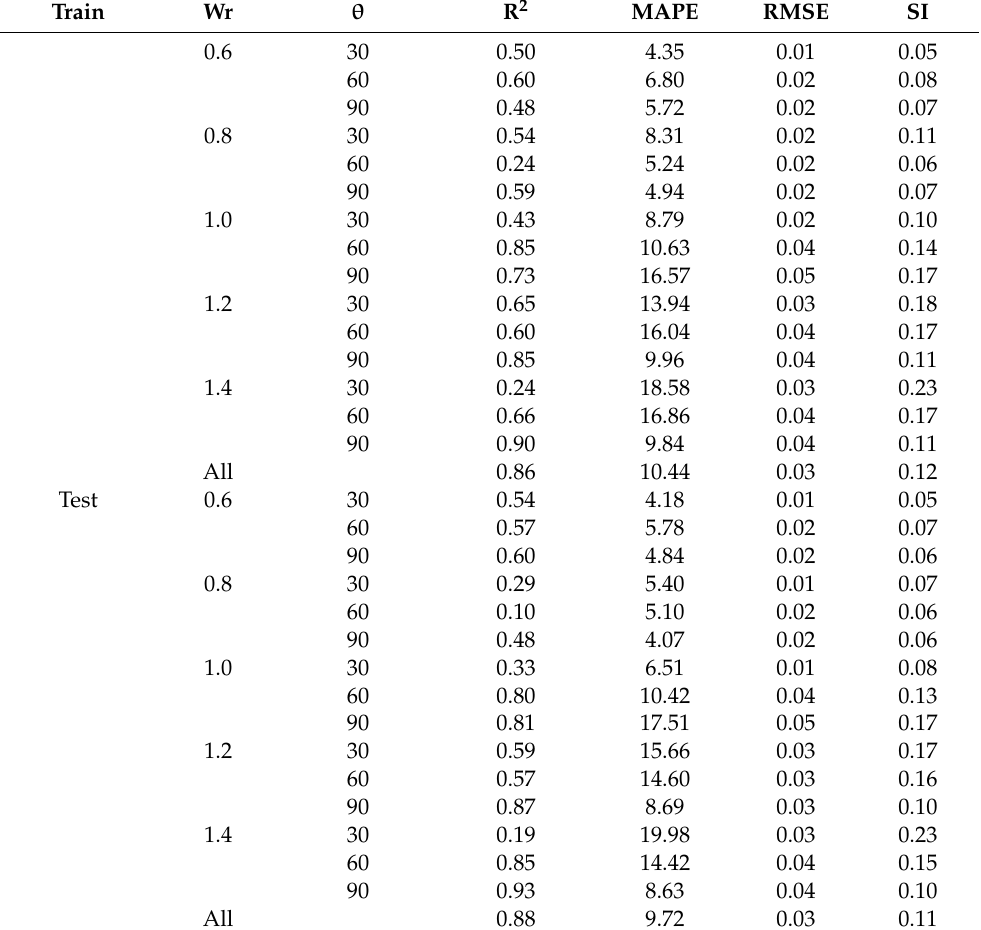
Table 2. Performance evaluation of presented model by GMDH for training and testing stage. Train